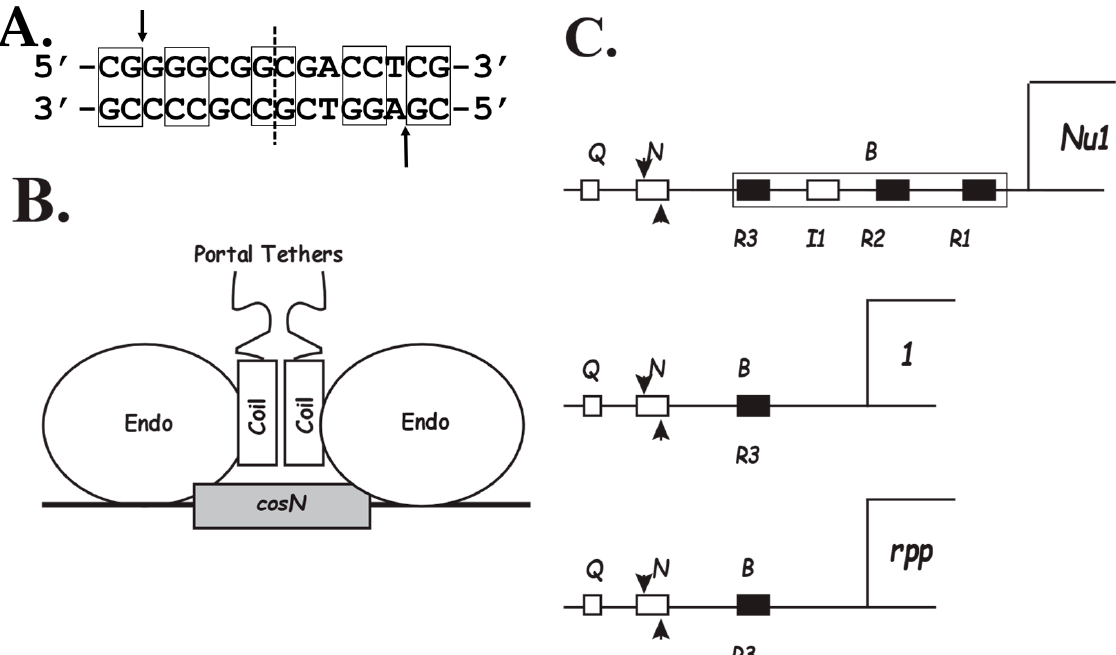
Figure 1. cos organization in λ -like phages and PICIs. ( A ). Sequence of cosN - λ : boxed bp show twofold rotational symmetry, where the dashed vertical line indicates the center of symmetry. Arrows indicate nicking sites. Note two rotationally symmetric flanking bp on both sides of the cohesive end sequence. ( B ). Cartoon of the proposed arrangement of the TerL endonuclease centers on cosN . Distal to the endonuclease centers are α -helixes proposed to form a parallel coiled coil, followed by C-terminal tethers for docking on the portal [7,8]. ( C ). cos organizations of λ , N15, and a PICI. Arrowheads indicate nick positions. Top: cosB - λ includes IHF site I1 and three R sequences. The start codon for TerS-encoding gene Nu1 is at bp 191. Middle: cos of phage N15 contains a single R se- quence, R3, and no IHF site. The start codon for TerS-encoding gene 1 is at bp 89. Bottom: